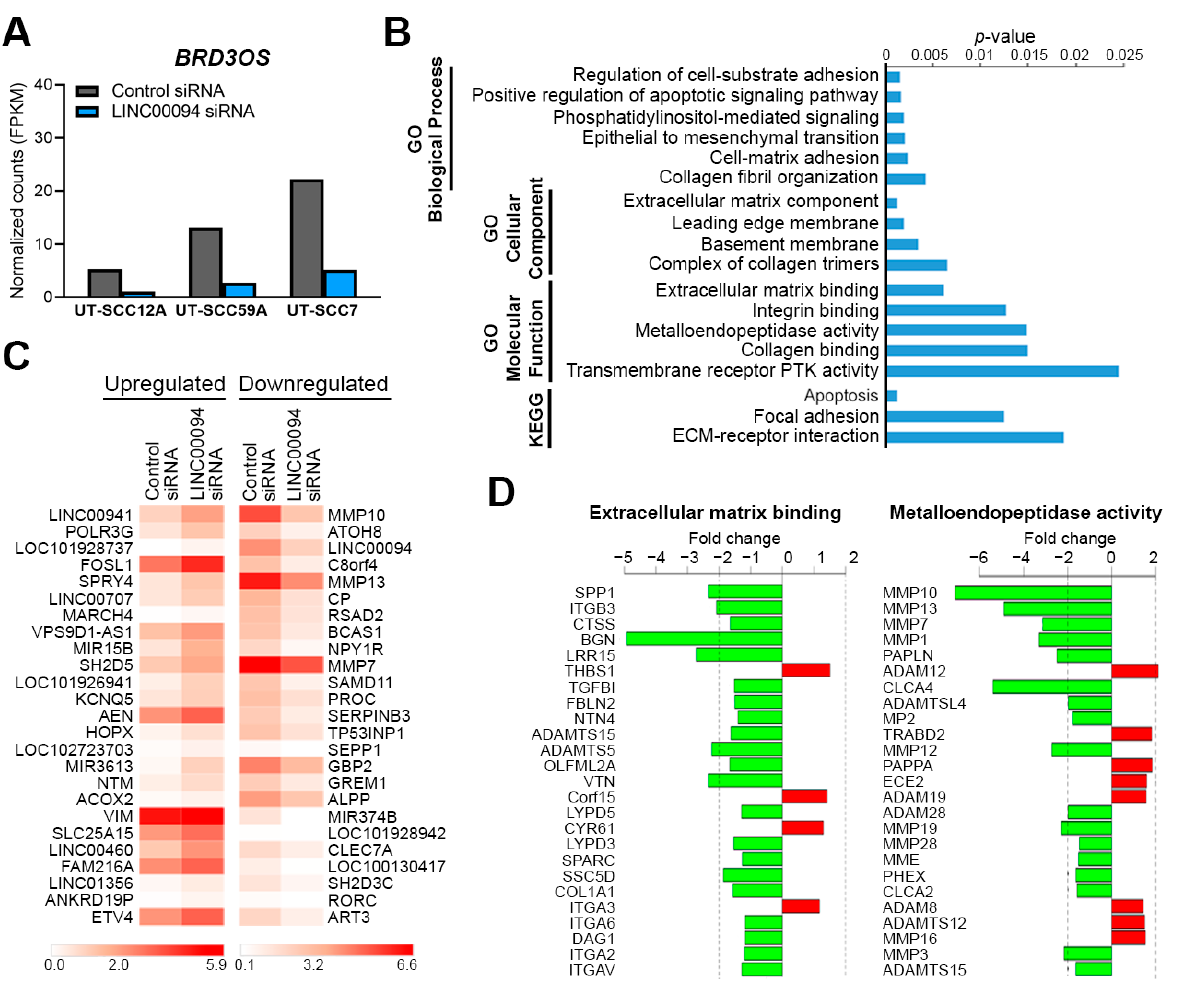
Figure 4. RNA-seq analysis of BRD3OS ( LINC00094 ) knockdown cSCC cells. cSCC cells were transfected with negative control siRNA or BRD3OS siRNA4, and after 3 days, total RNA was isolated, and RNA-seq was prepared. ( A ) BRD3OS ( LINC00094 ) knockdown efficiency in three cSCC cell lines (UT-SCC12, UT-SCC59A, and UT-SCC7) in the RNA-seq analysis. ( B ) Gene enrichment analysis showing the top Gene Ontology (GO) and Kyoto Encyclopedia of Genes and Genomes (KEGG) terms of differentially expressed genes (full ranked list) in BRD3OS ( LINC00094 ) knockdown cSCC cells. ( C ) Heatmap showing the top 25 up- and downregulated genes (log2FC ≥ 1 or ≤− 1, p < 0.05) in BRD3OS ( LINC00094 ) knockdown cSCC cells. ( D ) Gene plots showing the top 25 ranked genes included in the respective GO terms.